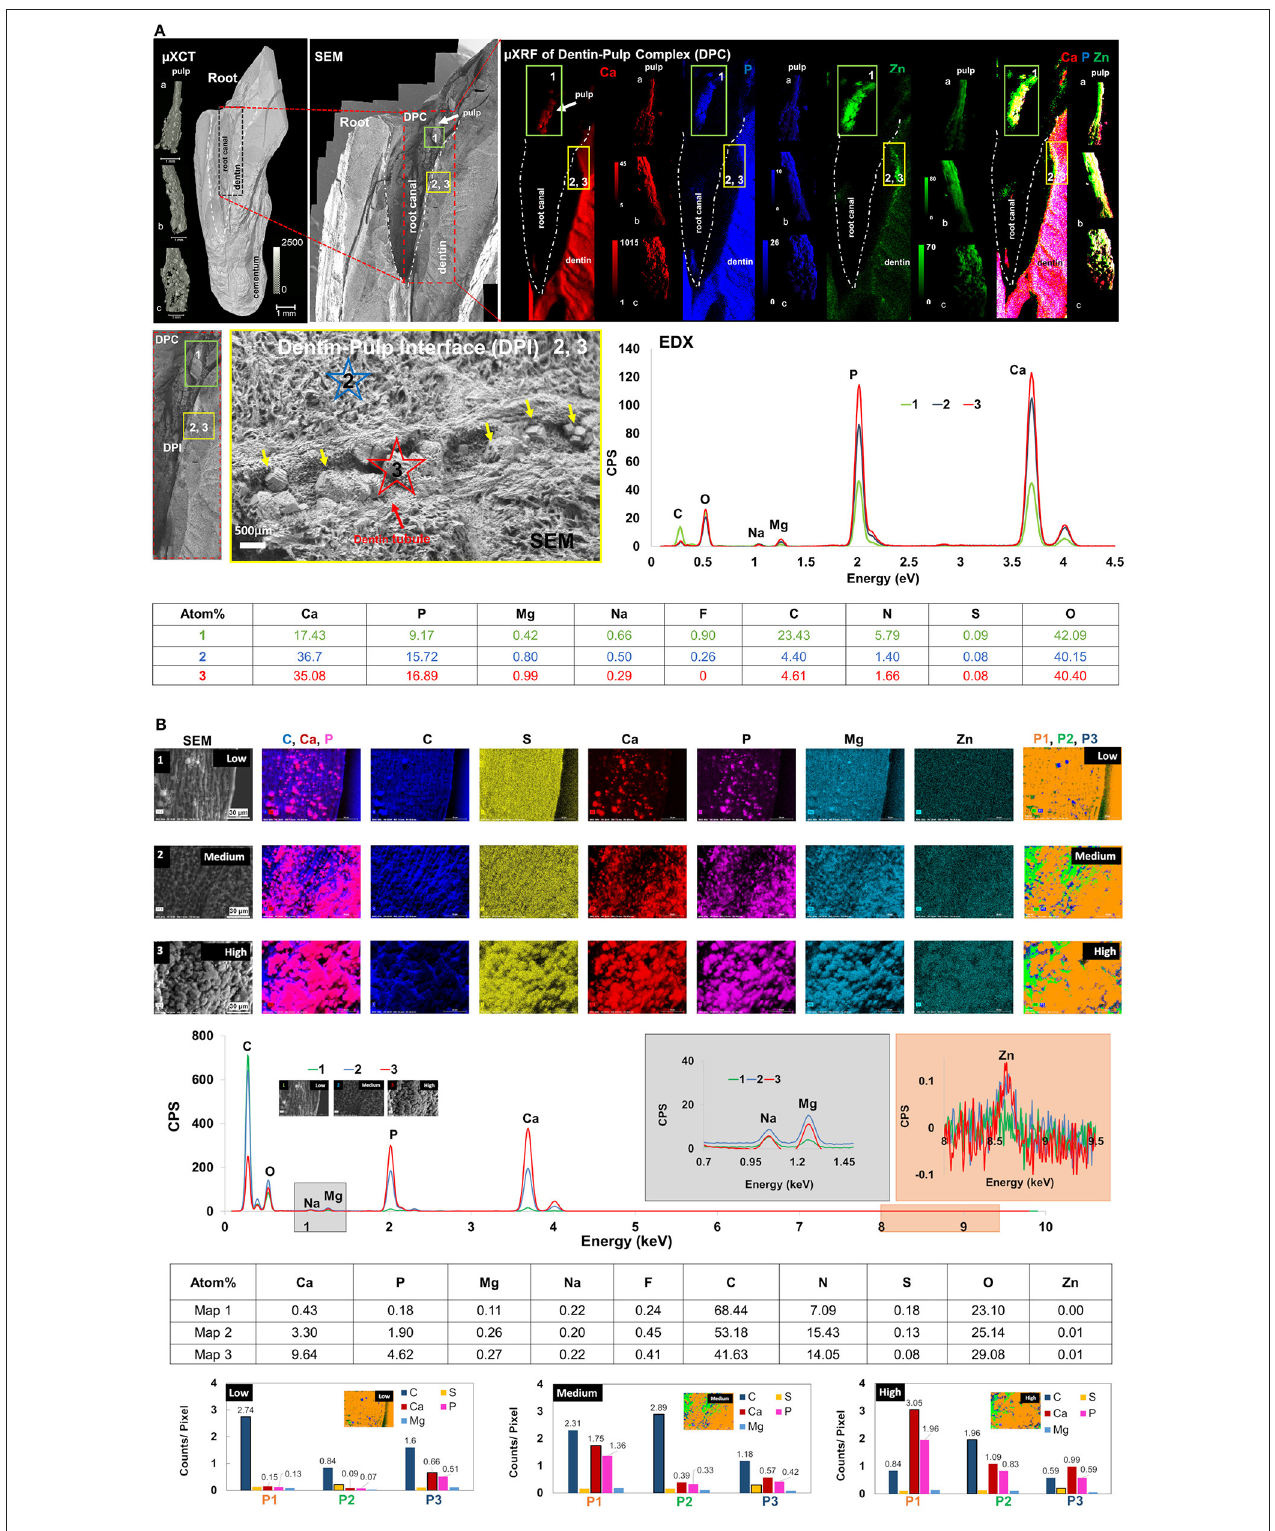
FIGURE 5 | Zinc and magnesium were co-localized in dentin-pulp complex (DPC). In particular, trace elements were colocalized at the dentin-pulp interface (DPI), within mineralized pulp, and in tubular occlusions within dentin. (A) (Top row, Left to right) Spatial maps of heterogeneous mineral densities (micro-XCT), matrix structure Dentin-pulp interface - DPI and regions 1-3, SEM), and element counts (calcium, phosphorus, magnesium and zinc counts) of root canal